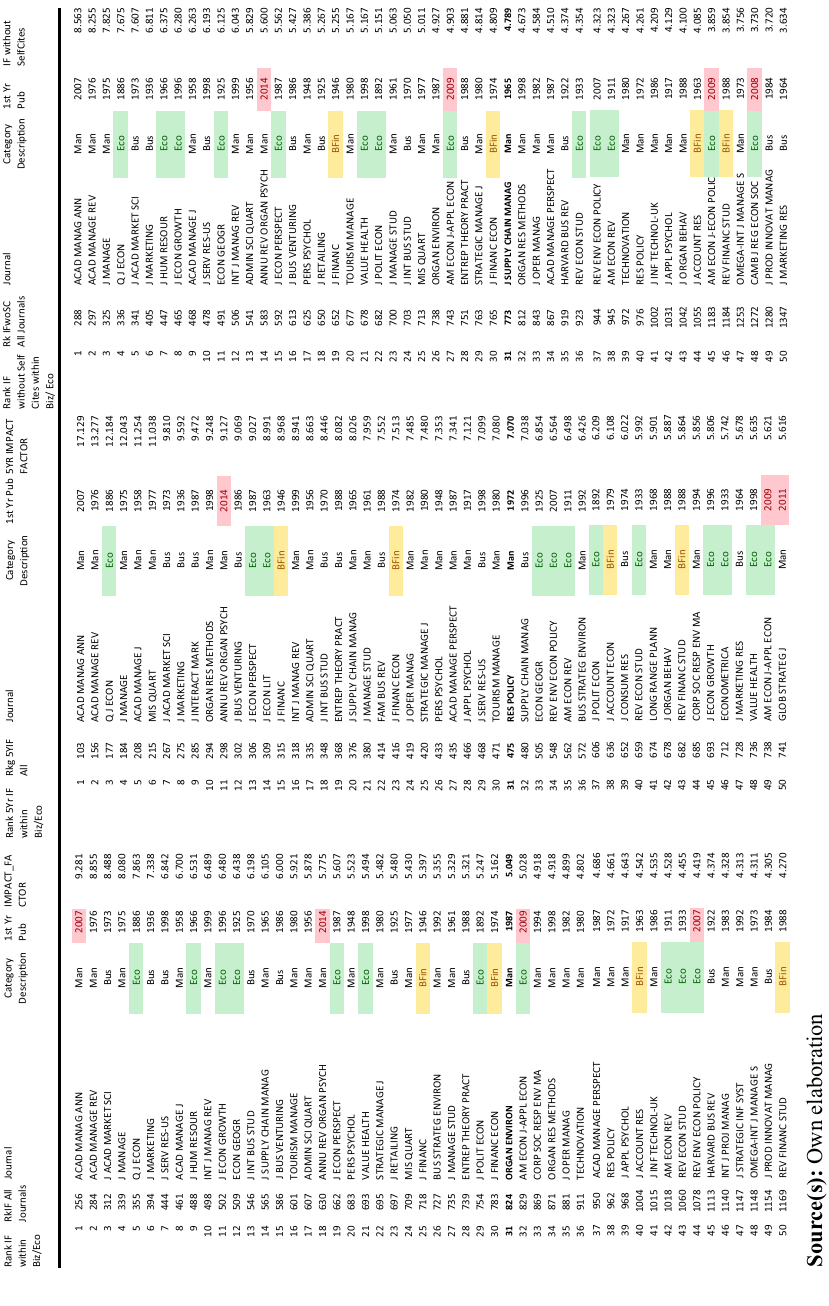
Business and Economics according to different journal metrics, rank based on impact factor